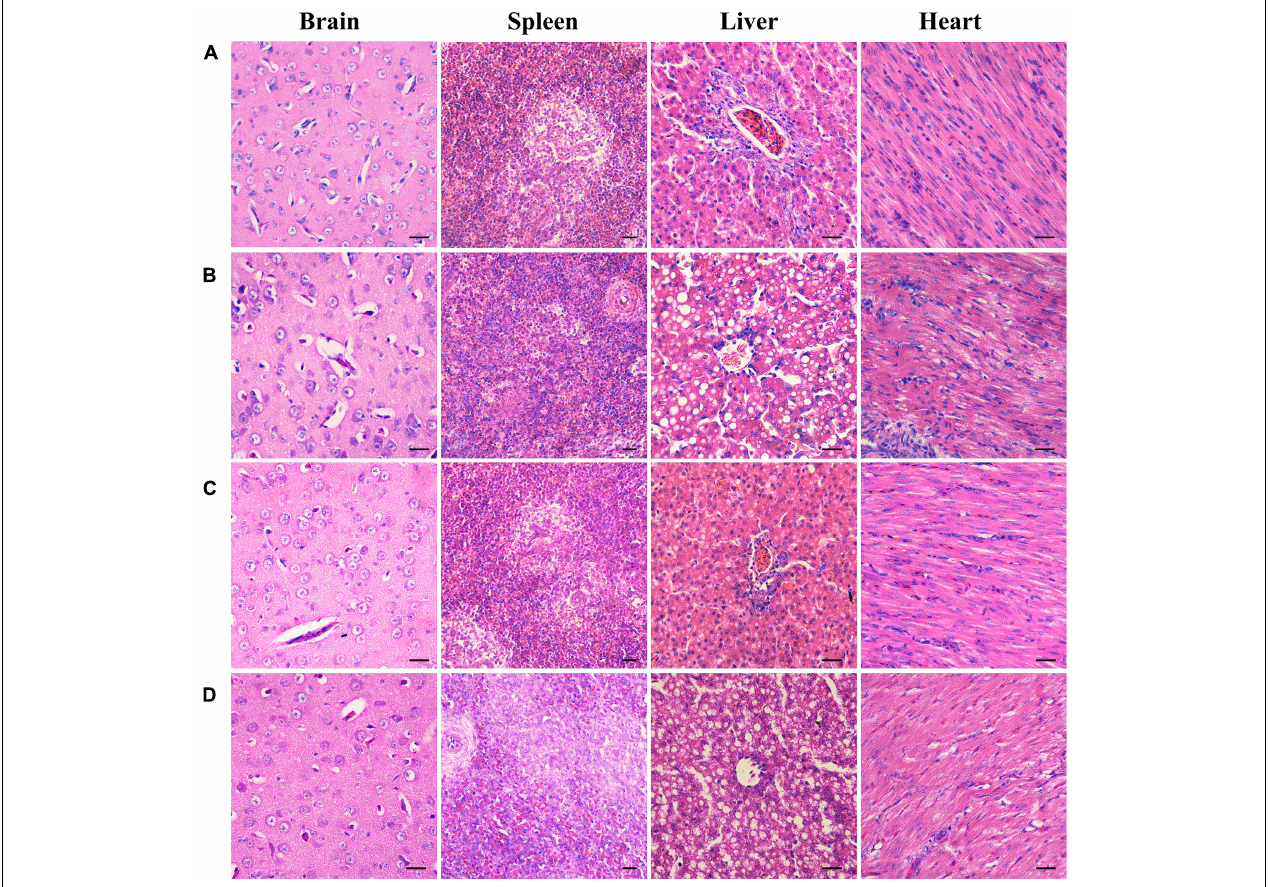
FIGURE 6 | Organ histopathological changes in ducks infected by R. anatipestifer . (A) Brain, spleen, liver, and heart samples from a healthy duck. (B) Corresponding samples from ducks infected by wild-type R. anatipestifer CH-1 at 36 h post-infection. (C) Corresponding samples from ducks infected by mutant strain (cid:49) B739_0832 at 36 h post-infection. (D) Corresponding samples from ducks infected by complement strain C (cid:49) B739_0832 at 36 h post-infection. For both brain and spleen tissues, samples from all three strains showed no lesions. For R. anatipestifer CH-1-infected ducks, obvious pathological changes were observed in liver and heart: liver cord disorder, a large area of vacuole-like changes and myocardial necrosis. (cid:49) B739_0832 mutant strain-infected ducks showed no pathological changes in liver and heart. C (cid:49) B739_0832 -infected ducks had the same histopathological changes as the wild-type strain. Tissue samples were stained with hematoxylin and eosin (400 × ). The size of the scale bar is 20.0 µ